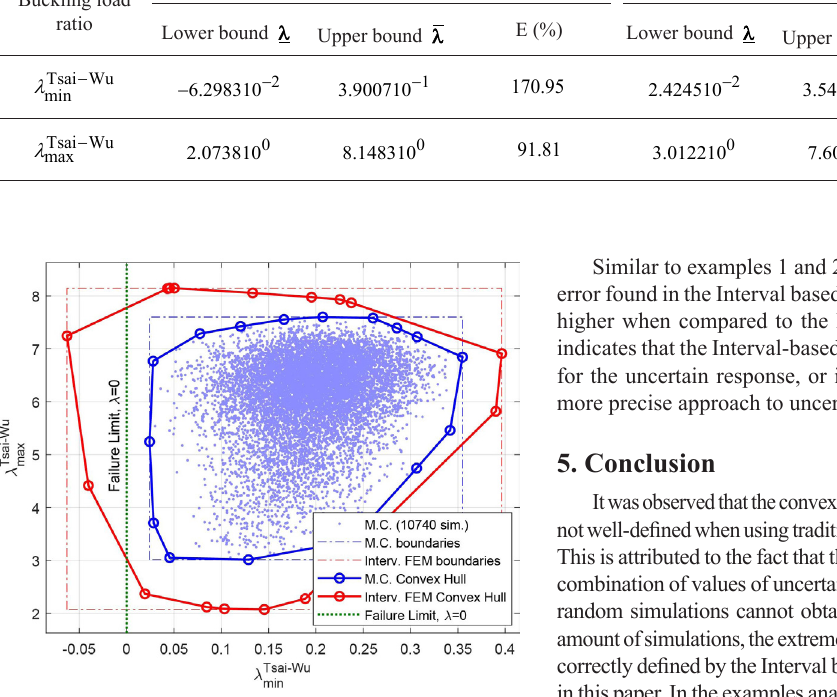
Figure 5. Output uncertain intervals and convex hull for the interval-based procedure and MC simulation for Tsai-Wu criterion, maximum and minimum λ